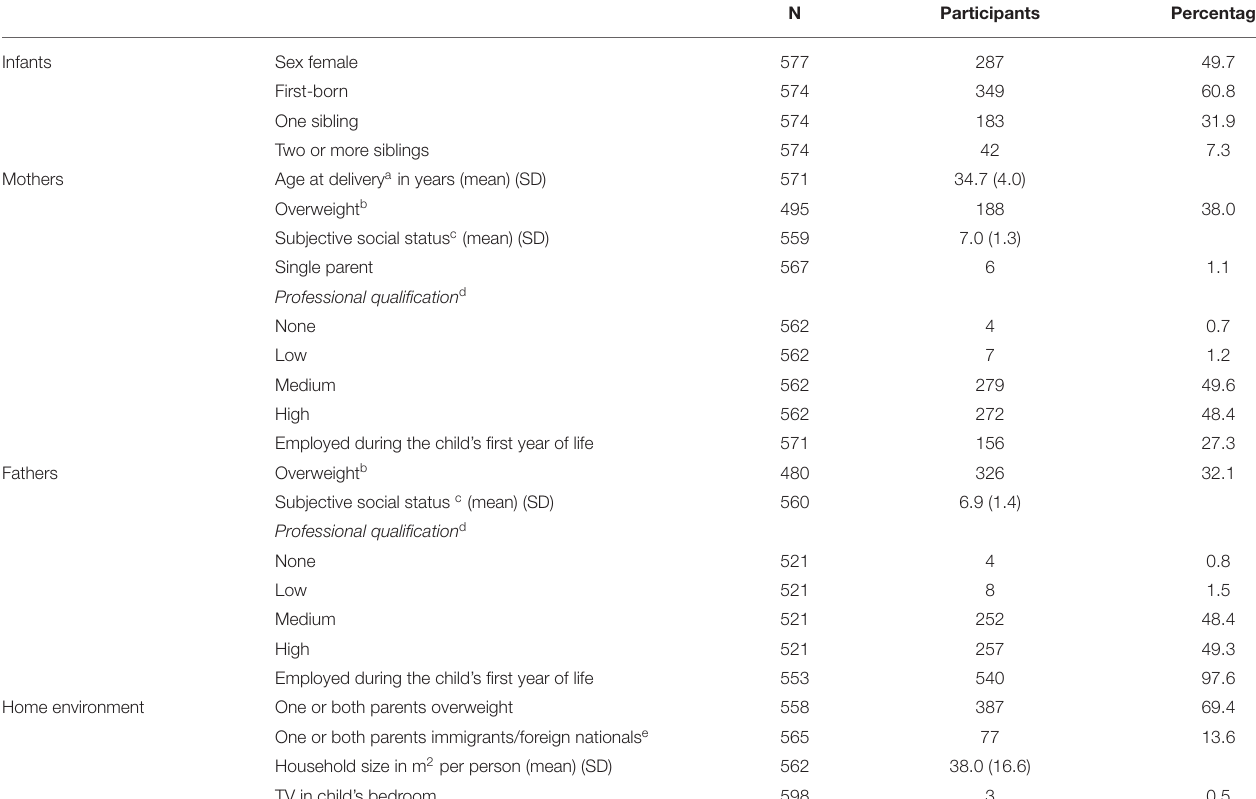
TABLE 1 | Characteristics of sample